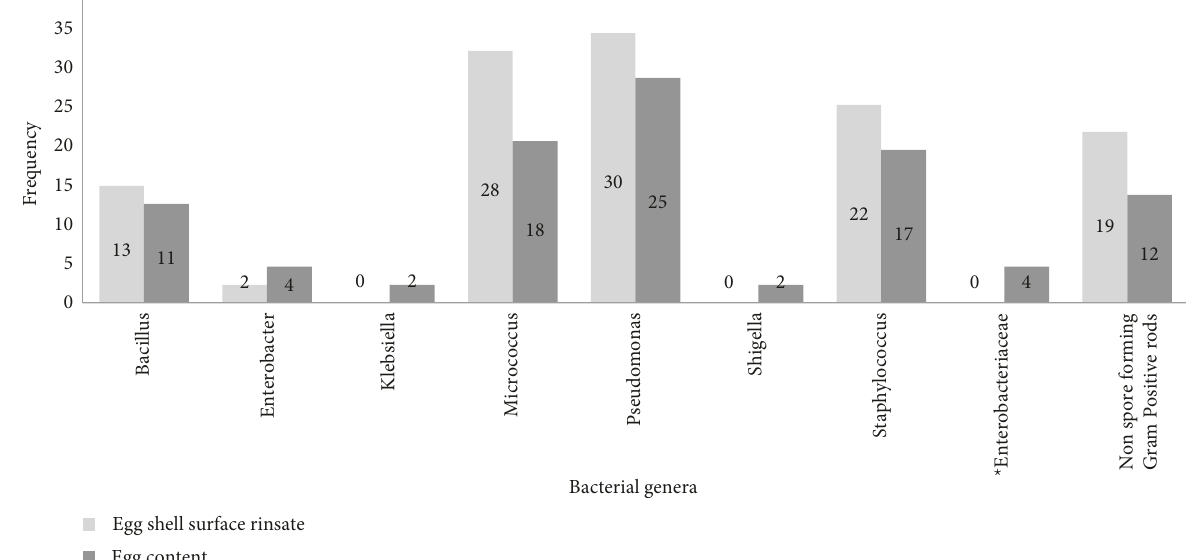
Figure 1: Frequency distribution of the dominant aerobic mesophilic bacterial genera isolated from the shell surface rinsates and contents of egg samples in Hawassa